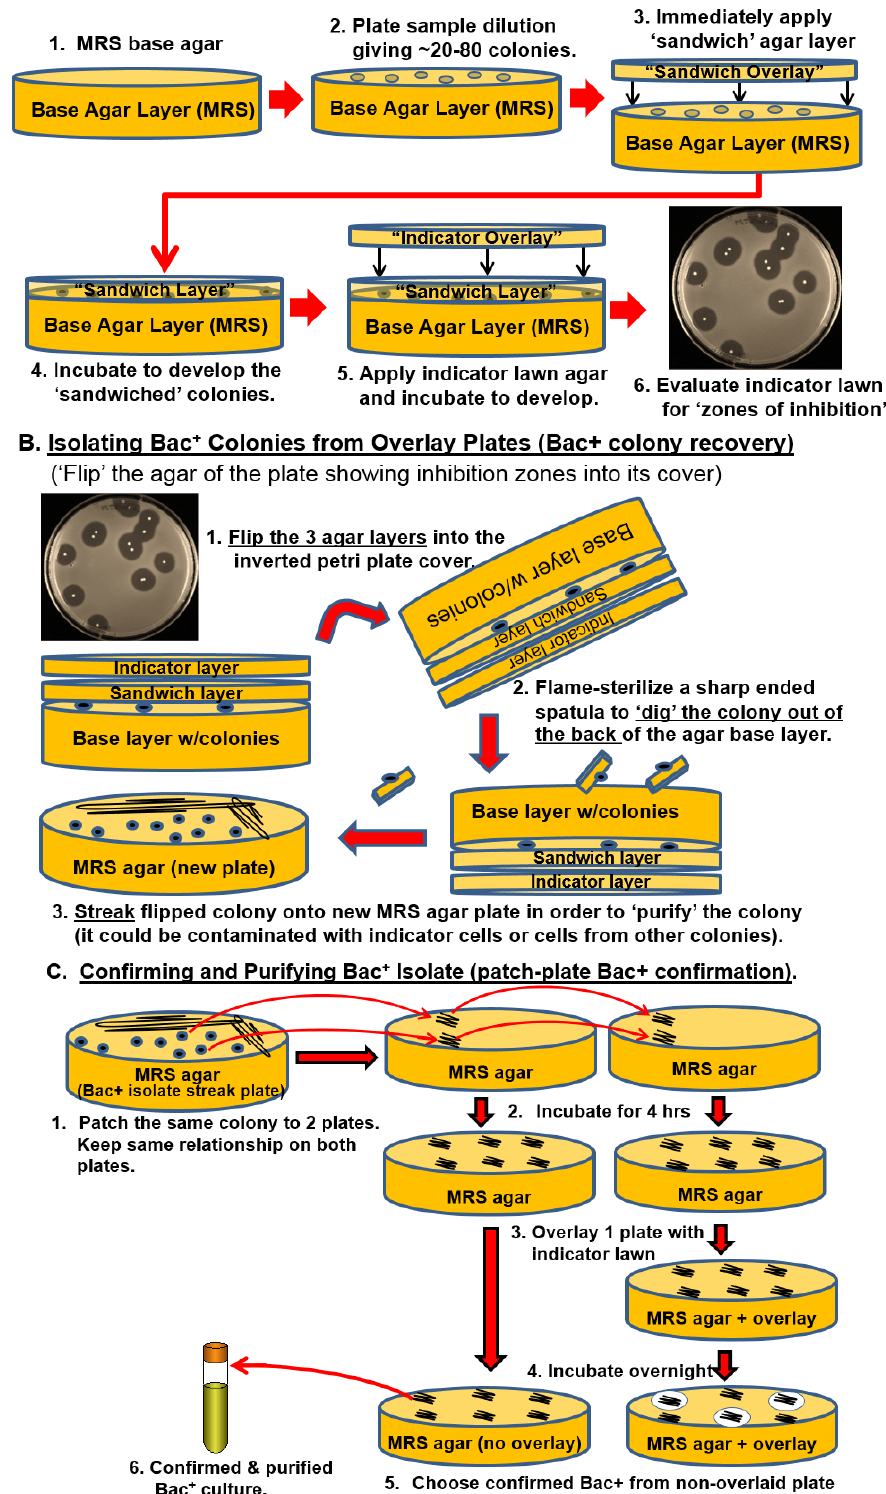
Figure 1. Various protocols used in this study. Panel A , colony overlay assay (deferred antagonism) to identify Bac + colonies by the sandwich-overlay technique. Panel B , isolation of Bac + colonies from sandwich overlay plates. Panel C , the double patch plate method for purification and confirmation of Bac + colonies and generation of the stock